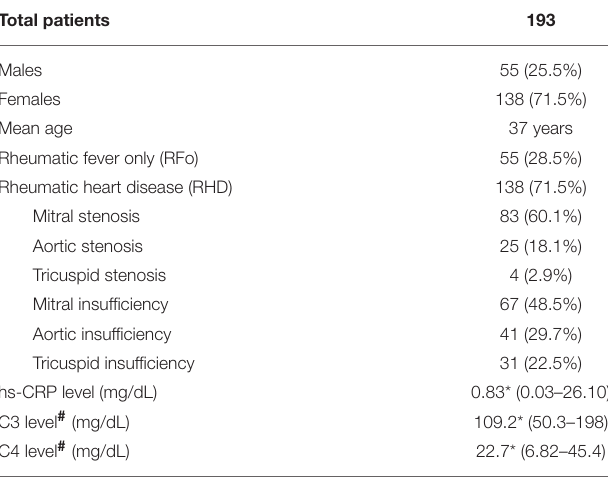
TABLE 1 | Clinical characteristics of patients.